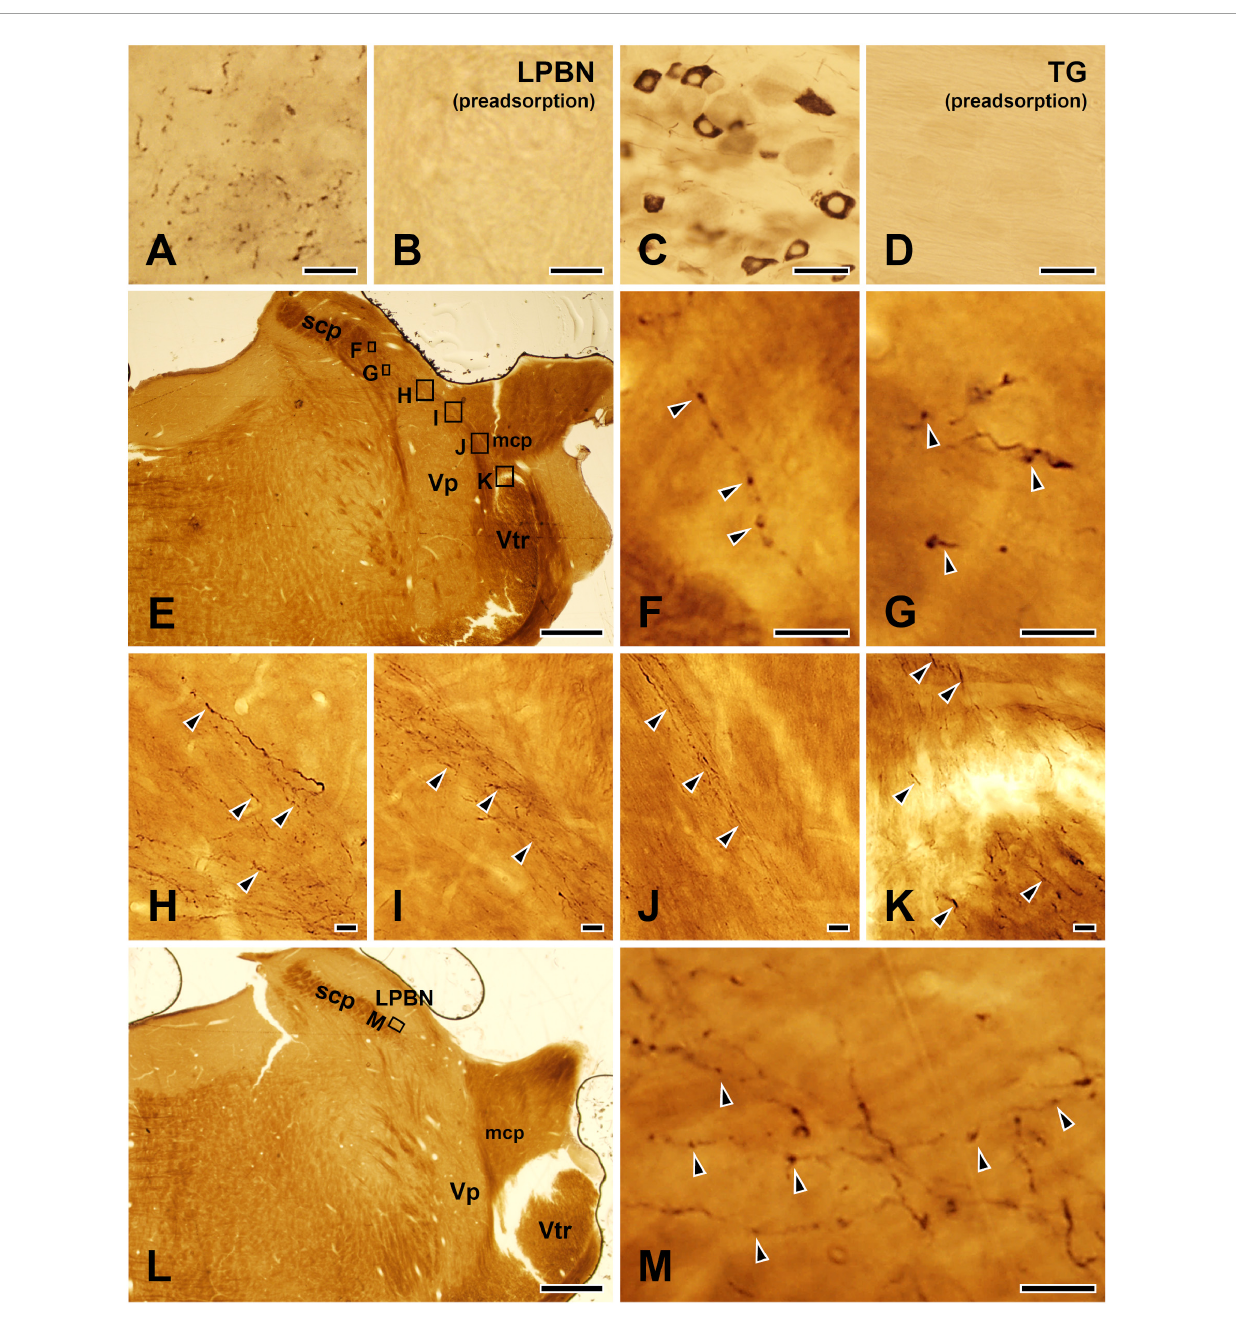
FIGURE1 Light micrographs showing immunostaining for TRPV1 in the lateral parabrachial nucleus (LPBN: A,B ) and the trigeminal ganglion (TG: C,D ), the TRPV1+ axons and terminals in the LPBN arising from the ascending trigeminal tract (E–K) , and examples of TRPV1+ axon terminals in the LPBN that were further analyzed by electron microscopy (L,M) . (A–D) Immunohistochemical staining for TRPV1 in the LPBN (A,B) and TG (C,D) . The TRPV1 immunostaining in the axons in the LPBN and neurons in the TG was completely abolished by pre-adsorption with a blocking peptide (10 µ g/ml), confirming the specificity of the TRPV1 antibody. (E–K) Light micrographs showing that the TRPV1+ axons and terminals in the LPBN (E–G) arise from the ascending trigeminal tract (Vtr: K ). These axons (K) course along the medial edge of the middle cerebellar peduncle (mcp: J ) and the dorsal border of the trigeminal principal nucleus (Vp: H,I ) and issue axon collaterals and terminals in the LPBN (F,G) . (L,M) Examples of TRPV1+ axons and terminals in the LPBN that were further studied by electron microscopy. (F–K,M) Are enlargements of the boxed areas in panels (E,L) , respectively. Arrowheads indicate TRPV1+ axons and terminals. scp, superior cerebellar peduncle. Scale bars = 10 µ m in panels (A,B,F–K,M) , 50 µ m in panels (C,D) and 500 µ m in panels (E,L)